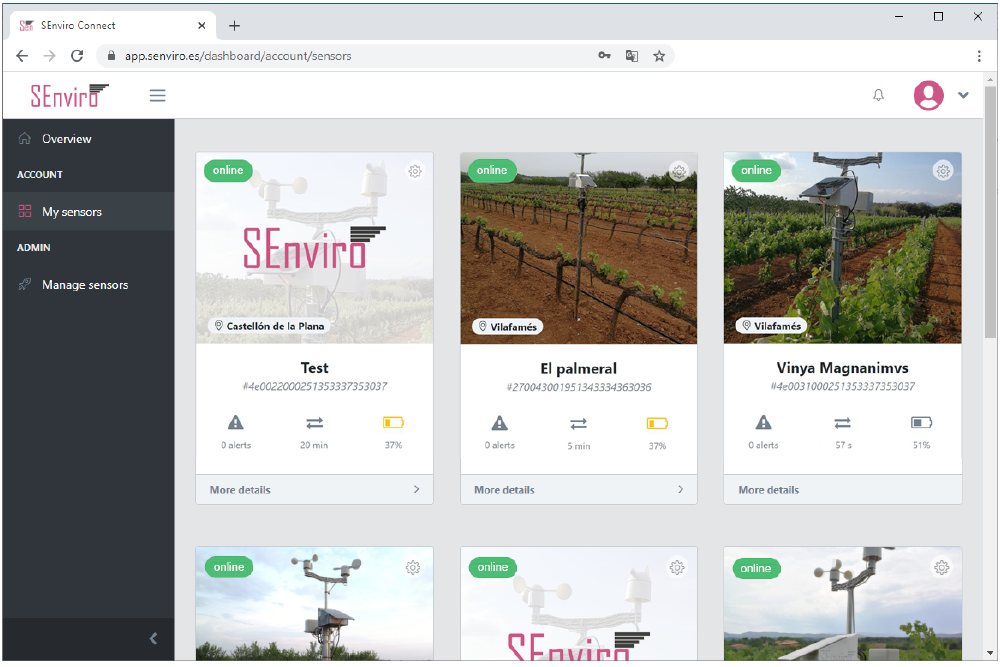
Figure 11. A screen capture of the SEnviro connect, where it shows the IoT device management view.